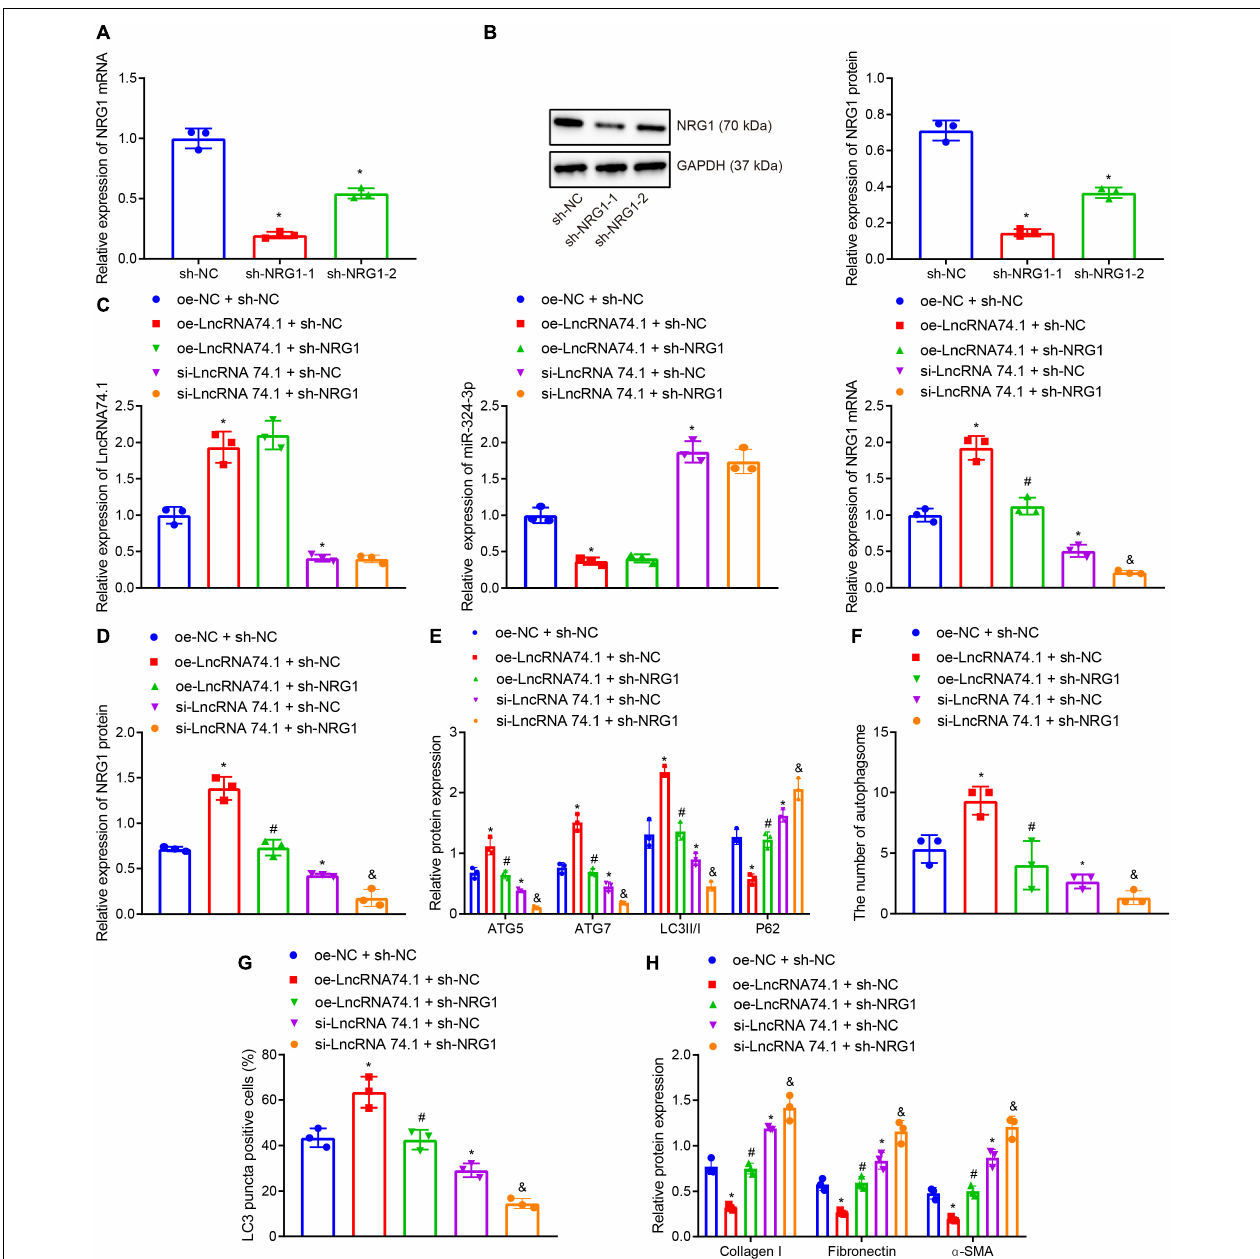
FIGURE 5 | NRG1 silencing inhibits the lncRNA 74.1-induced autophagy to aggravate renal fibrosis. (A) The efficacy of NRG1 silencing by RT-qPCR; (B) the efficacy of NRG1 silencing by Western blot; (C) RT-qPCR results of the expressions of lncRNA 74.1, miR-324-3p, and NRG1 mRNA in HK-2 cells with different treatments; (D) Western blot results of NRG1 protein expression in HK-2 cells with different treatments; (E) level of autophagy-related proteins by Western blot; (F) TEM observation of autophagosomes in HK-2 cells with different treatments; (G) proportion of LC3 positive cells in the HK-2 cells with different treatments by immunofluorescence assay; (H) the protein levels of fibrosis markers in HK-2 cells with different treatments by Western blot; * p < 0.05 as compared with oe-NC + sh-NC; # p < 0.05 as compared with oe-lncRNA 74.1 + sh-NC, & p < 0.05 as compared with si-LncRNA74.1 + sh-NC. The measurement data were expressed as mean ± standard deviation. One-way ANOVA was used for data comparisons among multiple groups, followed by Tukey’s post hoc test. The cell experiments were repeated three times independently.